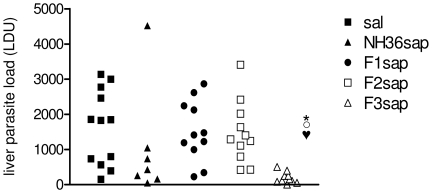
Protective efficacy of vaccinated mice against L. chagasi infection.The individual L. chagasi liver parasite load of vaccinated and control groups is expressed in LDU values (number of amastigotes per 600 liver cell nuclei/mg of liver weight) of 2 independent experiments, each with 4–8 mice per vaccine group. *p<0.05 significant differences from the saline controls,  from the F1sap and ○ from the F2sap vaccines. The mean averages of LDU values are: 1632.64 (sal); 1027.50 (NH36sap); 1806.49 (F1sap); 1469.91 (F2sap) and 192.14 (F3sap).